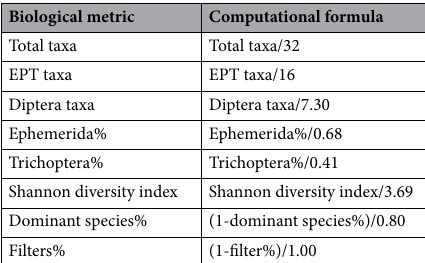
Biological metric